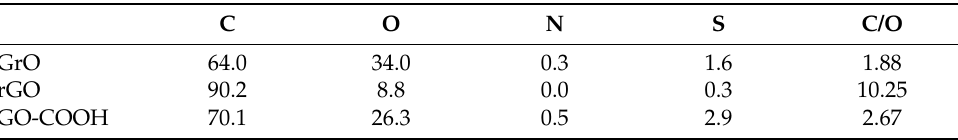
Table 1. Surface elemental relative atomic composition (at-%) of C, O, N and S determined by XPS peak integration, as well as the C/O